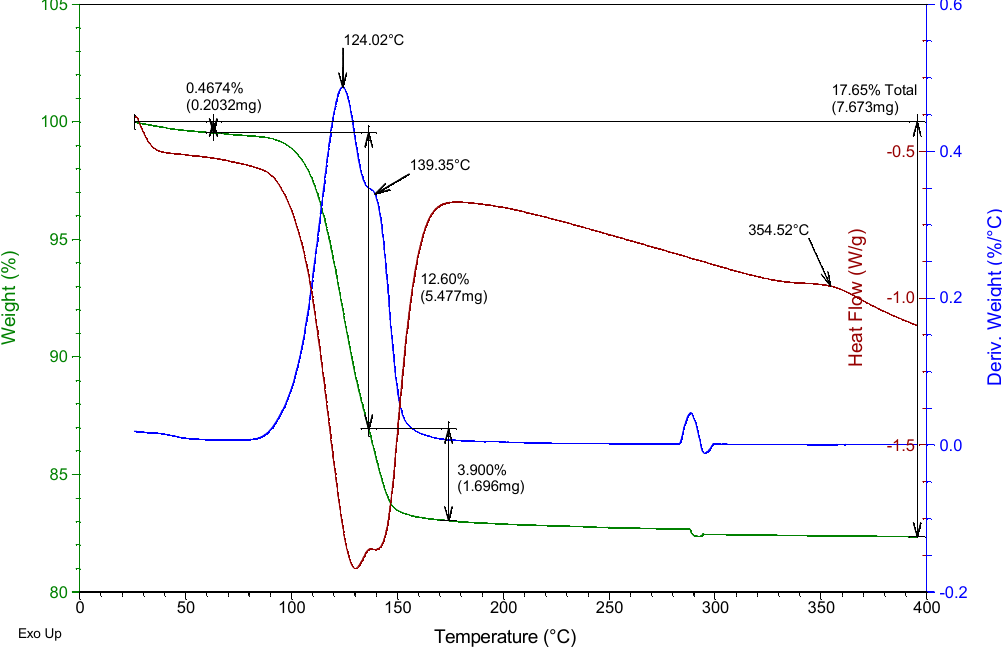
Figure 12. Thermogravimetric analysis of the YF-0.8 test tube aged 7 days.